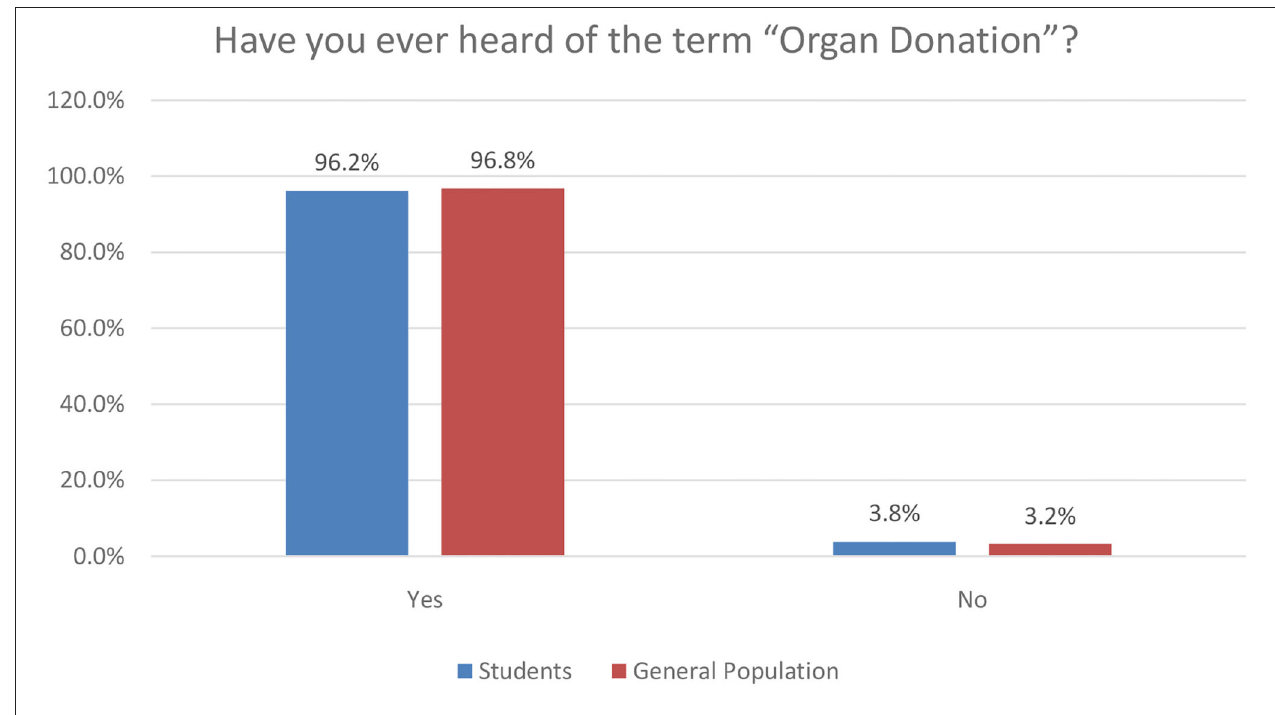
FIGURE 7 | Awareness on organ donation.